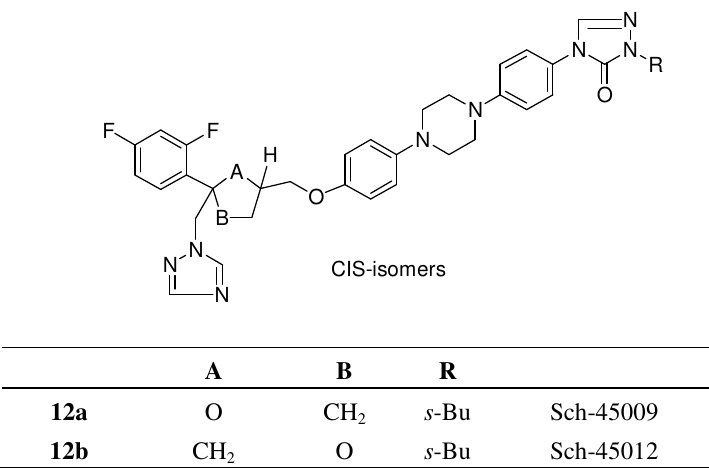
Figure 5. Tetrahydrofuryl isosters of